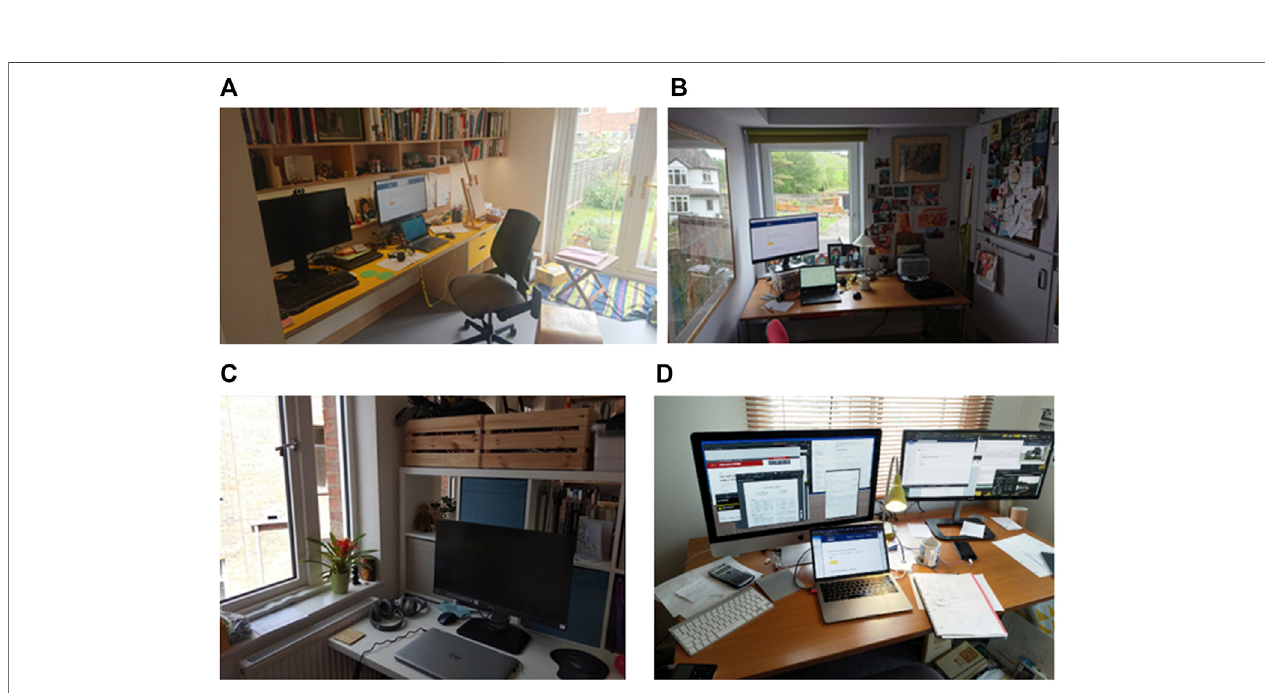
FIGURE 4 | Visual cues and peripheral